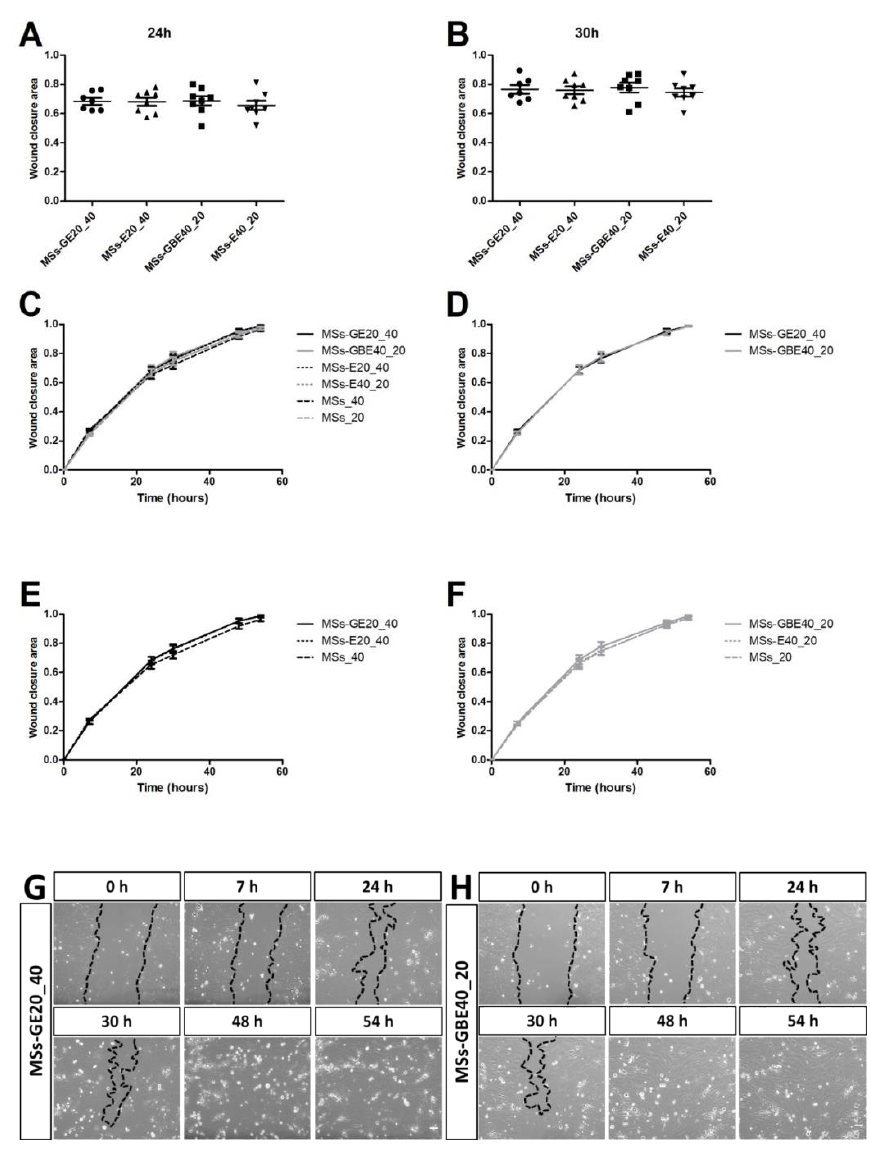
Figure 5. Wound closure in RF/6A cells represented by scatter plot and representative images. No statistically significant differences were found at 24 and 30 h ( A , B ) post-scratching. Moreover, wound closure pattern were similar for both treatments, MSs-GE ( − ) and MSs-GBE ( − ) in RF/6A cells at 0, 7, 24, 30, 48 and 54 h after scratch as shown in graphs ( C – F ) and representative images ( G , H ). Black dotted lines indicate the wound borders at the different time points and treatments. Blank MSs (MSs_20) and (MSs_40); GDNF/VitE(20)-loaded PLGA MSs (MSs-GE20_40); GDNF/BDNF/VitE(40)-loaded PLGA microspheres (MSs-GBE40_20). Scale bar: 100 µm. n = 7–9.